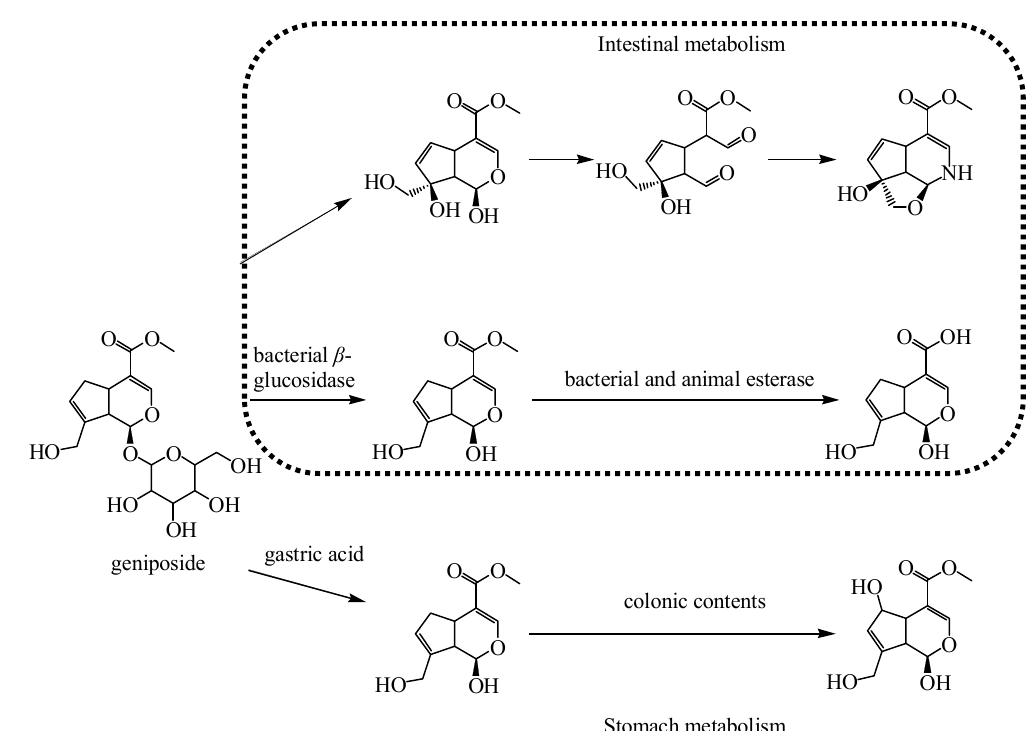
Figure 7. The metabolic processes of geniposide.